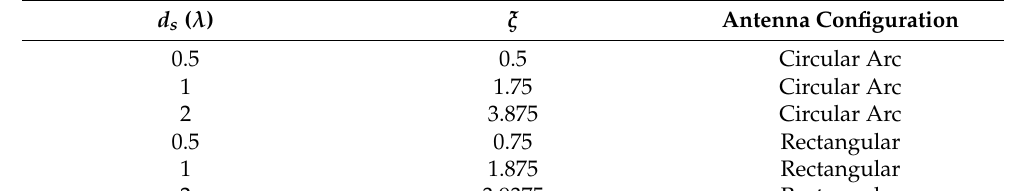
Figure 7. Channel capacity at different aspect ratios ξ : ( a ) ξ = 2 n ; ( b ) ξ = 2 n − 1 Table 2. Parameters of theoretical maximum capacity.